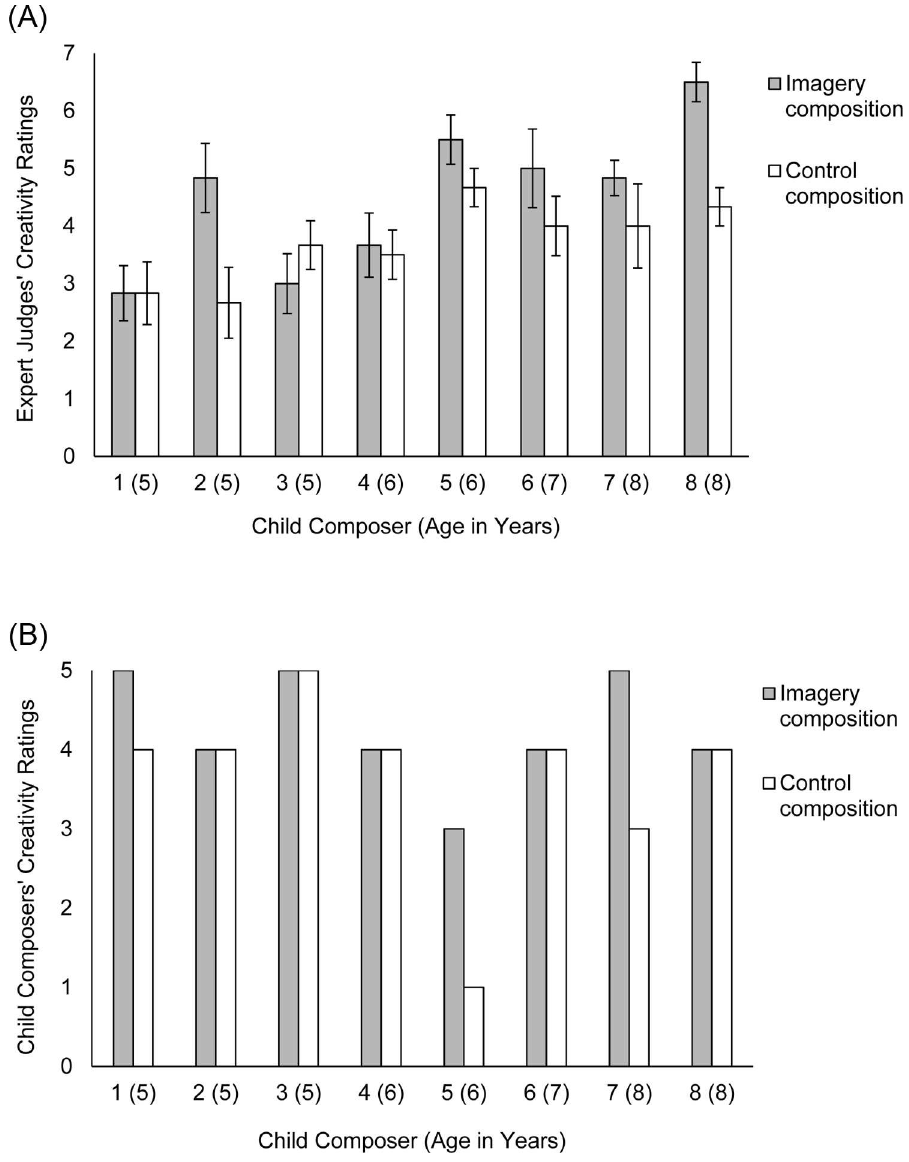
Fig 1. Creativityratings of individual child composers’ imagery and control compositions. (A) Expert judges’( N = 6) ratings, on a 7-point scale, of each child composer’simageryand control compositions. Error bars represent standard errors. (B) Individualchild composers’ratings, on a 5-point scale, of their own imageryand control compositions.